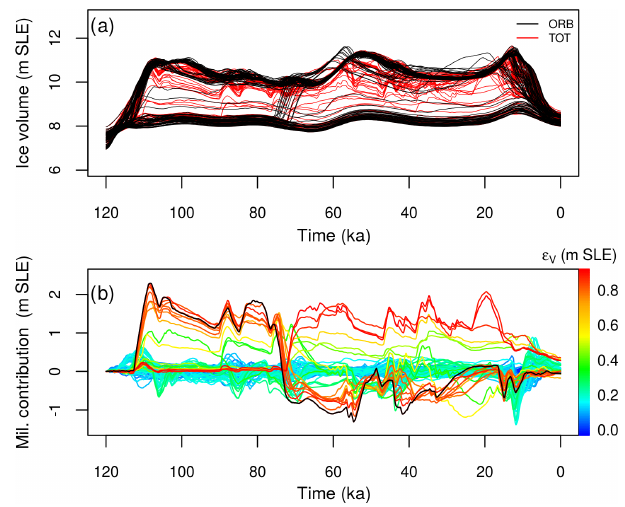
Figure 2. (a) Ice-volume evolutions simulated by ORB (black curves) and TOT (red curves) throughout the LGP (m SLE); (b) TOT-ORB ice-volume anomaly, intended as the oceanic millennial-scale variability contribution to the GrIS ice-volume variation (m SLE; positive values indicate ice gained by TOT with respect to ORB). The colour scale indicates the root mean square deviation ( ε ) calculated in terms of ice-volume residuals between TOT and ORB simulations (m SLE). Black line in (b) refers to the simulation corresponding to the maximum GrIS response to millennial-scale variability in the